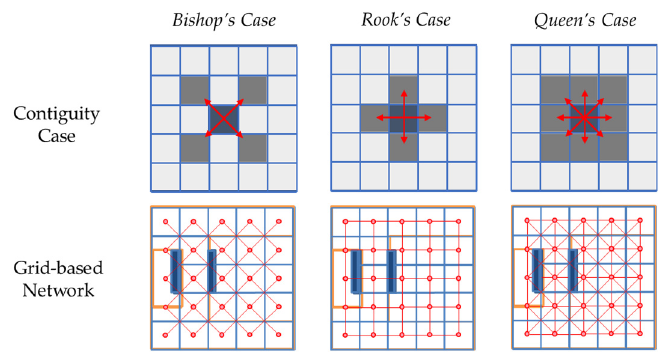
Figure 6. Contiguity cases for defining connectivity of grids.